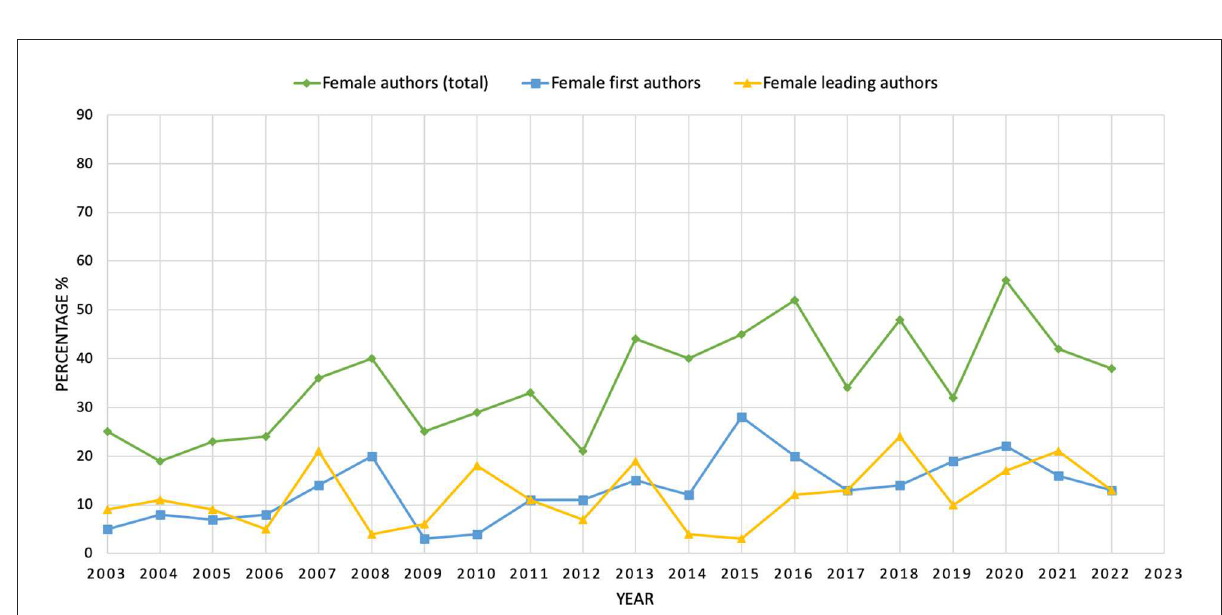
FIGURE2 Percentages of female authors (total, first, or as lead authors) in PerCom from 2003 to